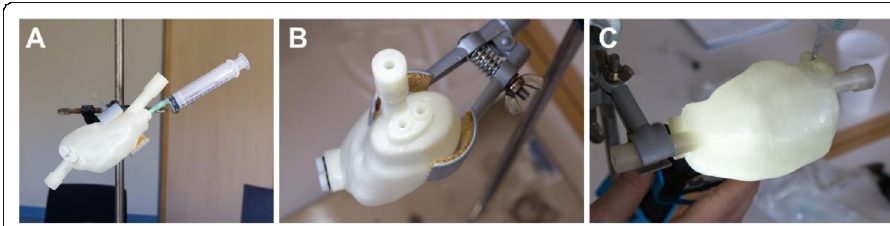
Fig. 2 Filling procedure for the kidney insert. A Filling of the medulla with the kidney mounted in a clamp stand. B Medulla filling holes. C Bottom-lit kidney to visualize the filling level